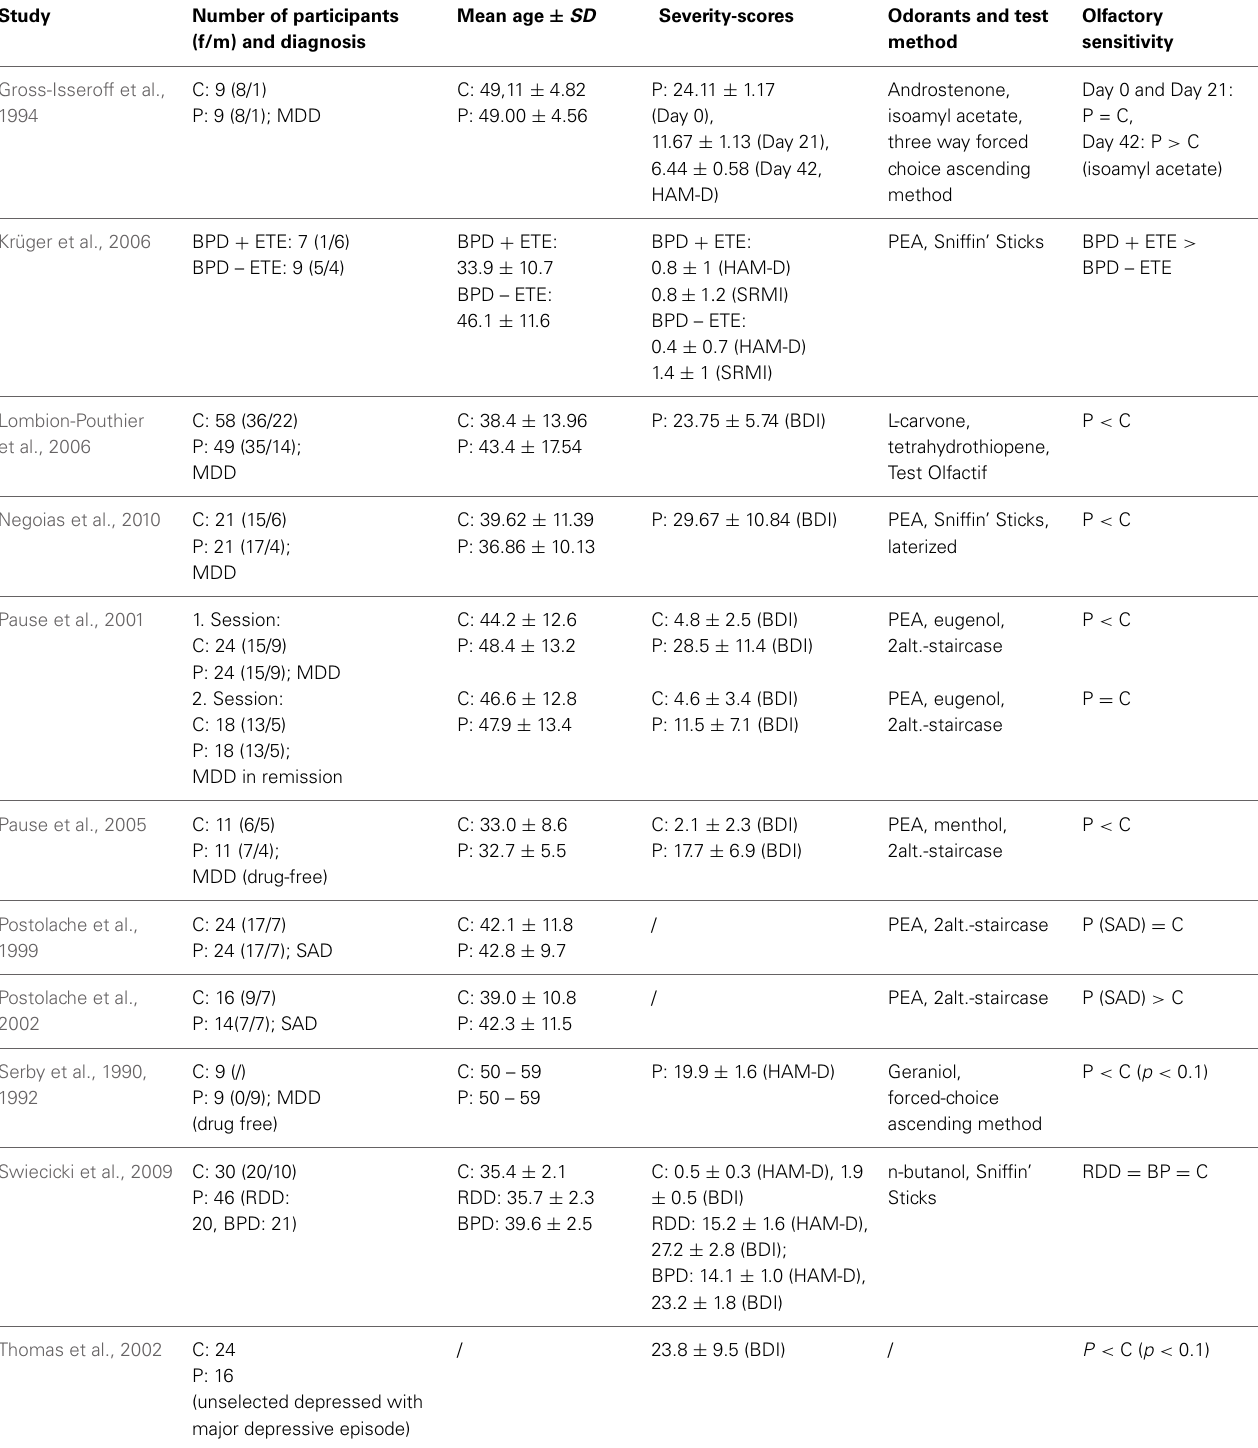
Table 1 | Summary of studies of olfactory sensitivity in affective disorders. Study Number of participants Mean age ± SD Severity-scores Odorants and test (f/m) and diagnosis